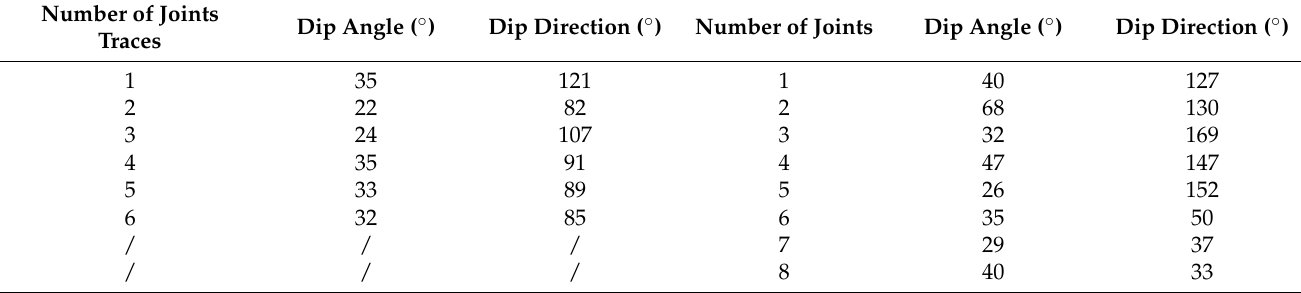
Figure 15. The distribution of joint traces and occurrences. ( a ) Trace measurement of joints. ( b ) Oc- currence measurement of joints. Table 2. Detailed information on the joint traces and occurrences.